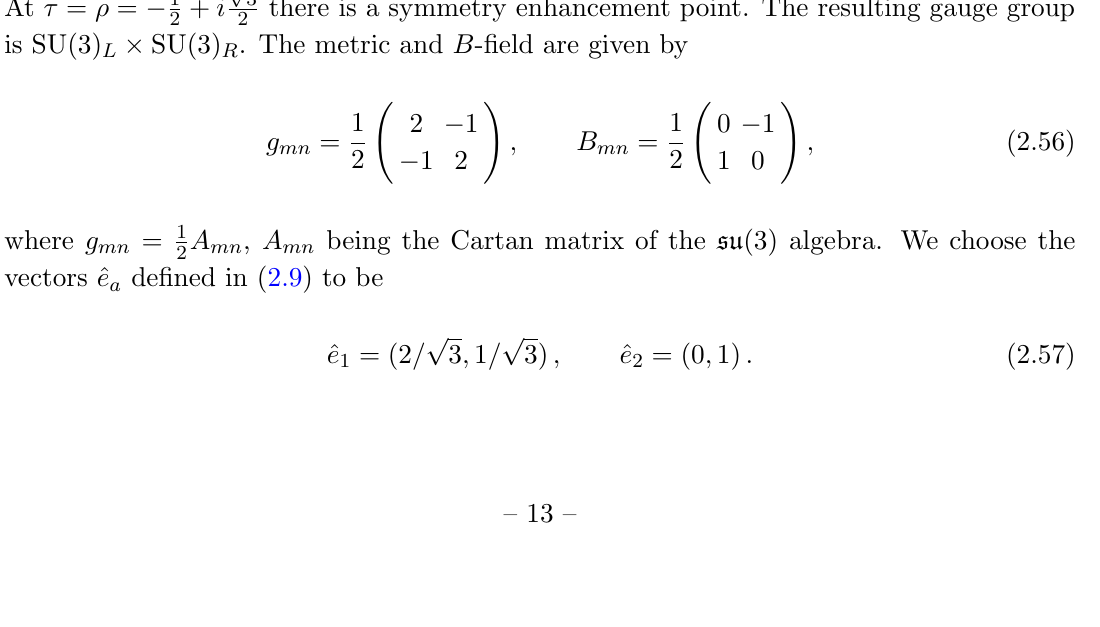
At this point there are 12 massless vectors and 36 massless scalars. The left vectors associated to the Cartan subalgebra are given by (2.29) and those associated to the ladder operators by (2.30), where now the (cid:11) in (2.30) are the roots of the su (2) 2 algebra. For the left gauge group, the massless ladder vectors at (cid:28) = (cid:26) = i are those in table 2.1. There is an identical construction for the right sector, with appropiate n and w i i